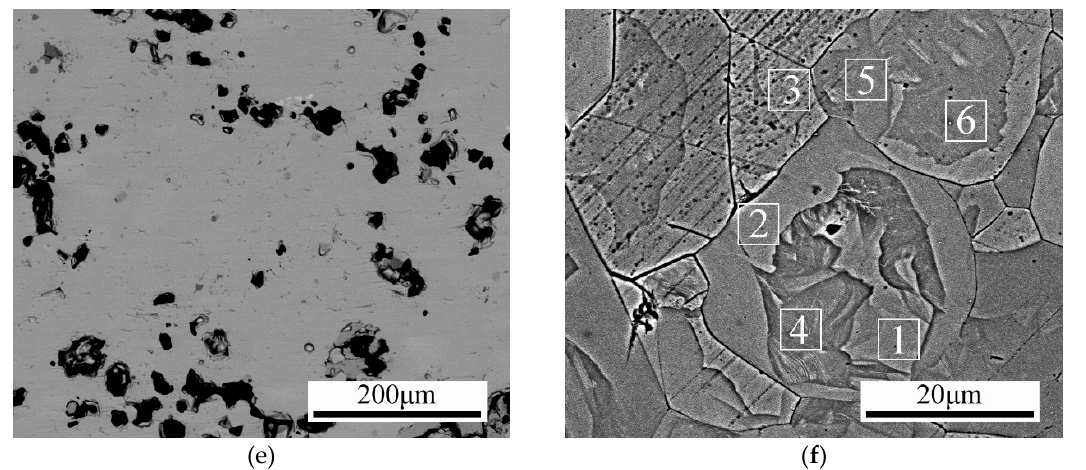
Figure 1. The microstructure of the La 0.8 Ti 0.1 Ga 0.1 Fe 3 CoSb 12 sample ( a ) as-quenched and annealed at 973 K for ( b ) 10 h, ( c ) 25 h, ( d ) 50 h, ( e ) 100 h and ( f ) the spinodal decomposition zone of the 100 h annealed sample.